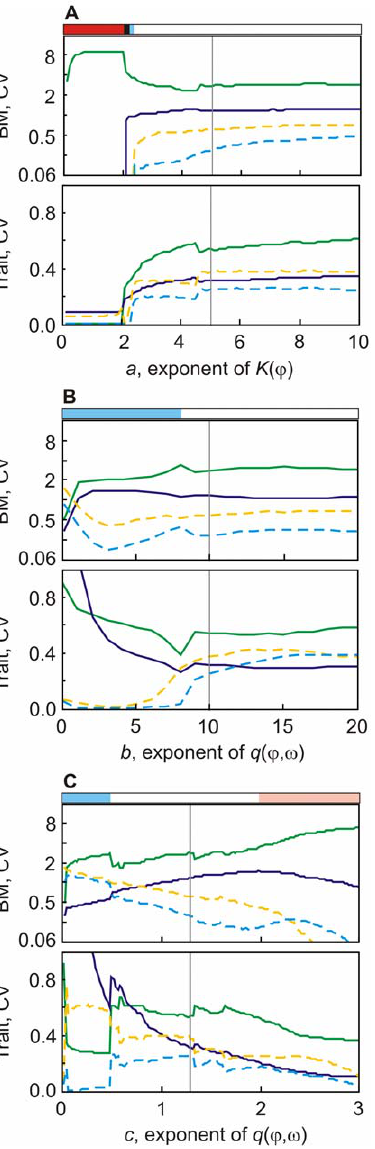
Figure 5. Sensitivity of the model behavior. Alterations in: ( A ) exponent a of the function K ( Q ) , Eq. (15), ( B ) exponent b of the function q ( Q , v ) , Eq. (16), and ( C ) constant c of the function q ( Q , v ) , Eq. (16). Each panel comprises 2 graphs: The upper graph shows the time averaged prey (black solid line) and predator biomasses (gray solid line) (g C m { 2 , log 2 scaled) and the respective CVs (dashed lines). The lower graph shows the time averaged trait values edibility (black solid line) and food-selectivity (gray solid line) and the respective CVs (dashed lines, CVs were only calculated for biomasses w 10 { 10 ). The vertical lines mark the standard parameter values as given in Table 1. The horizontal bars indicate the dynamics in the predator and prey biomass if they differ from those observed with the standard parametrization (cf. Table 1, Figure 1 D). Red bars indicate the extinction of the predator and a constant biomass of the prey at maximum carrying capacity, black bars indicate a fixed point with predator and prey coexisting (for an example see Figure 6 A). Light blue bars indicate regular predator-prey cycles, i.e., both predator and prey biomasses oscillate with the same frequency and a constant amplitude, with quarter-period phase-lags (for an example see Figure 6 B). Pink bars indicate regular predator-prey cycles with approximately half-period phase-lags (for an example see Figure 6 C). See text for